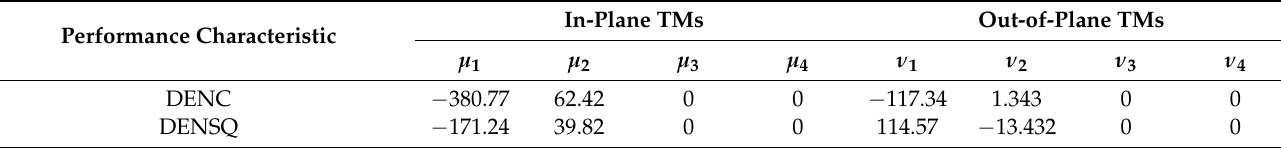
Table 10. Encircled Energy Characteristic Fit Coefficients,